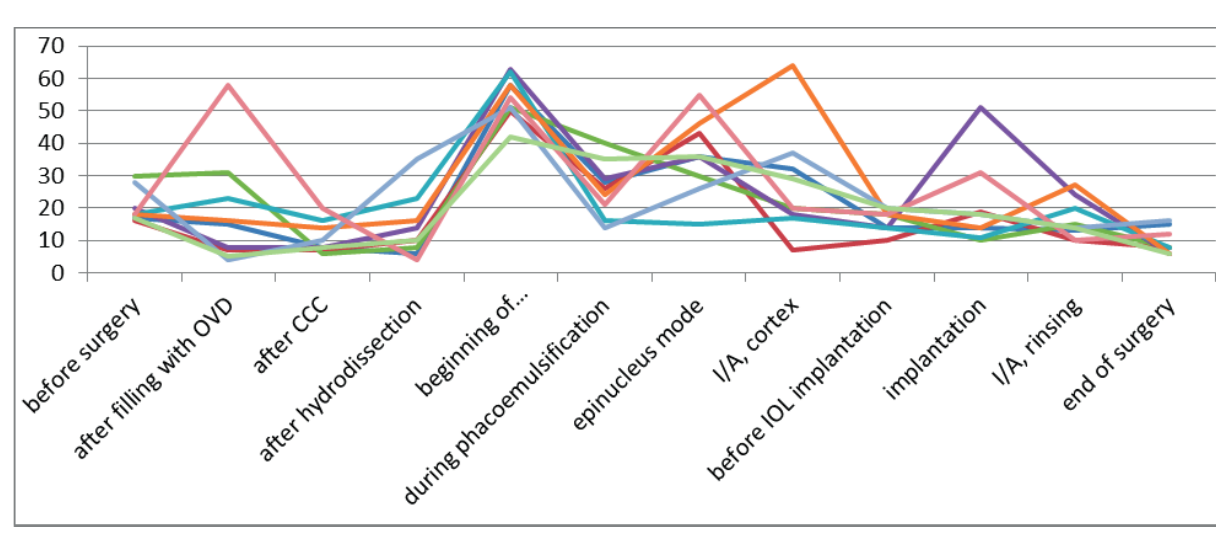
Fig. 1. IOP progression, measured in all ususal steps of phacoemulsification. (OVD – Ophthalmic Viscosurgical Device, CCC – continuous curvilinear capsulorhexis, I/A – irrigation/aspiration, IOL – intraocular